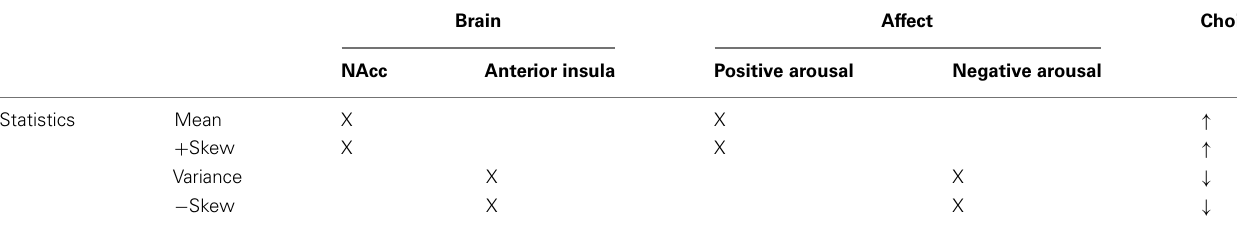
Table 4 | Predicted maximum activity organized by affective